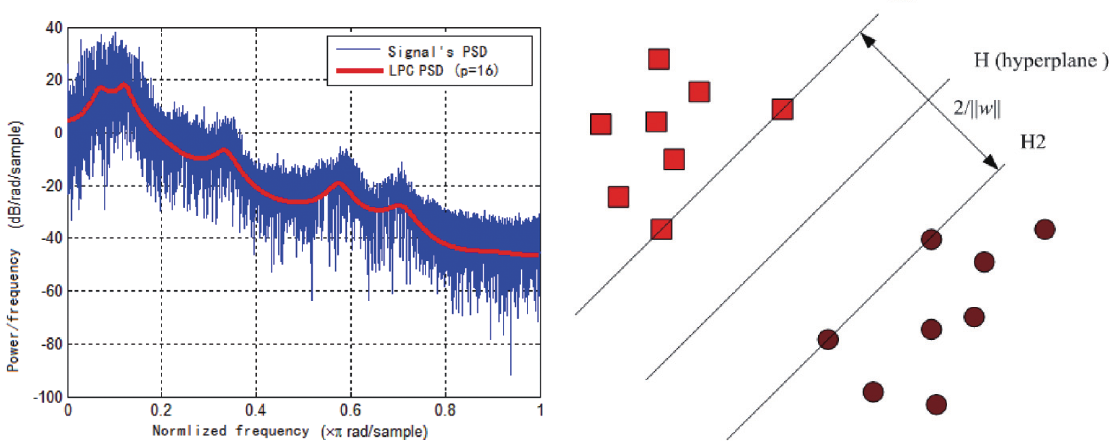
Fig. 8. Signal FFT spectrum and LPC estimated spectrum. Fig. 9. SVM optimal